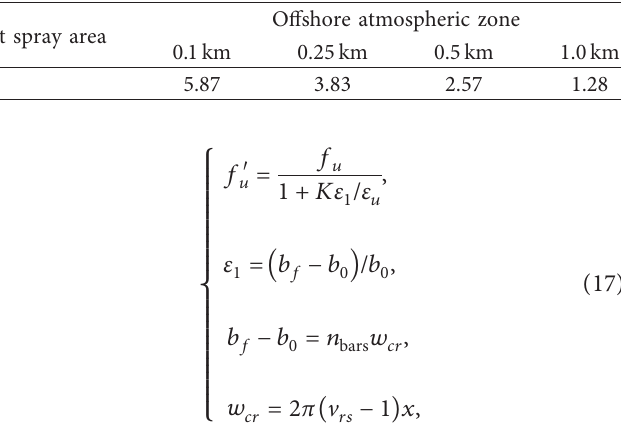
Table 1: Concrete surface chloride ion concentration C